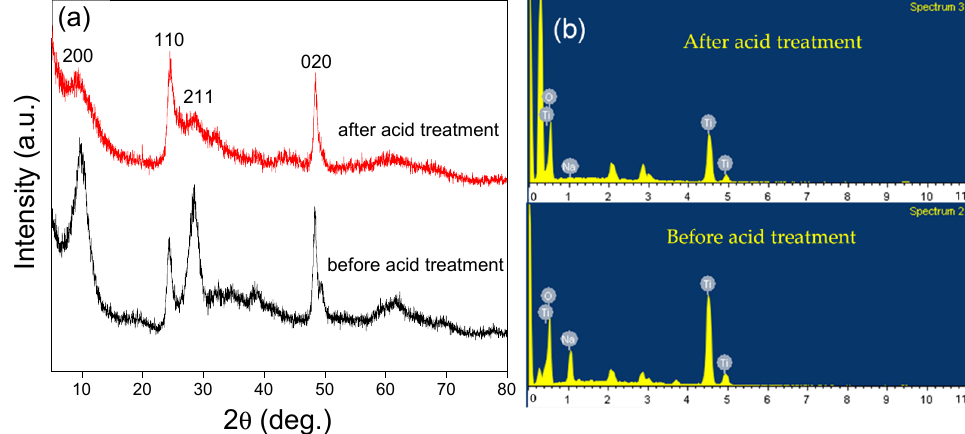
Figure 1. ( a , b ) Powder XRD patterns of titanate nanotubes showing the effect of acid treatment and EDX analyses before and after acid treatment.